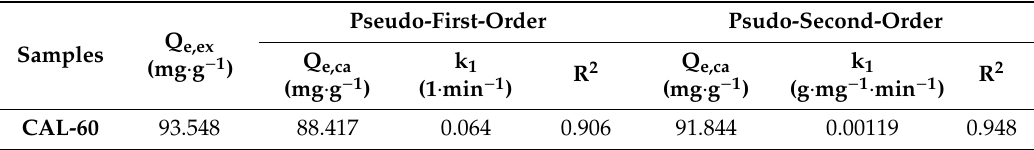
Table 1. Experimental data of Cl − uptake on CAL-60 and adsorption kinetics parameters obtained from two adsorption kinetics models.